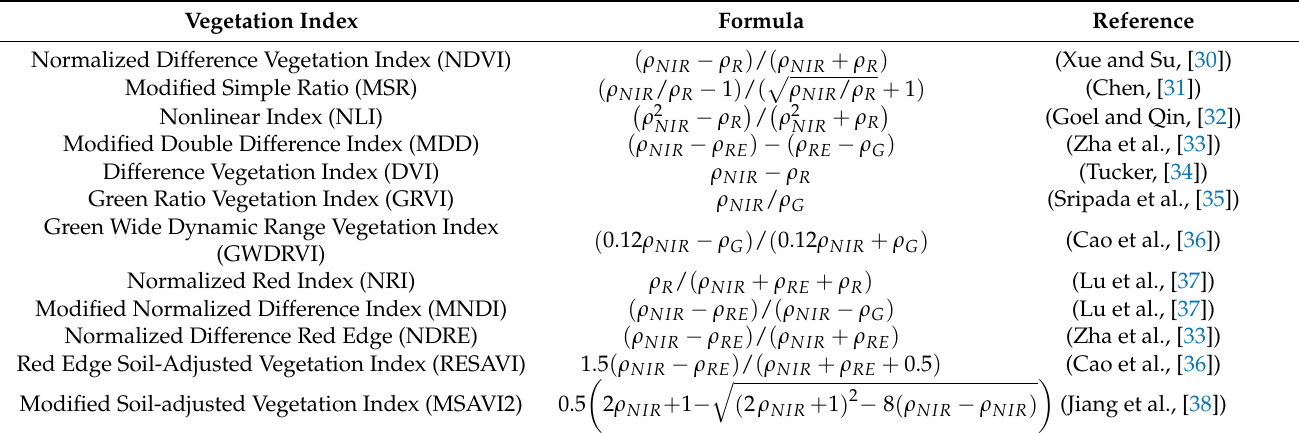
Table 2. Details of multispectral vegetation